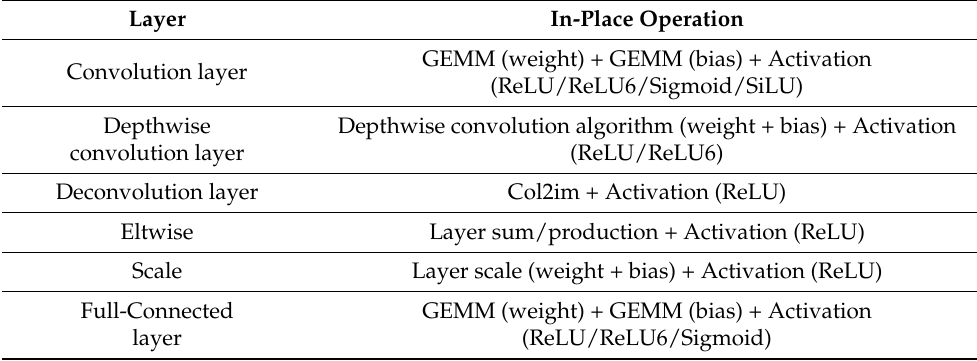
Table 3. List of operations in layers that provide in-place kernel